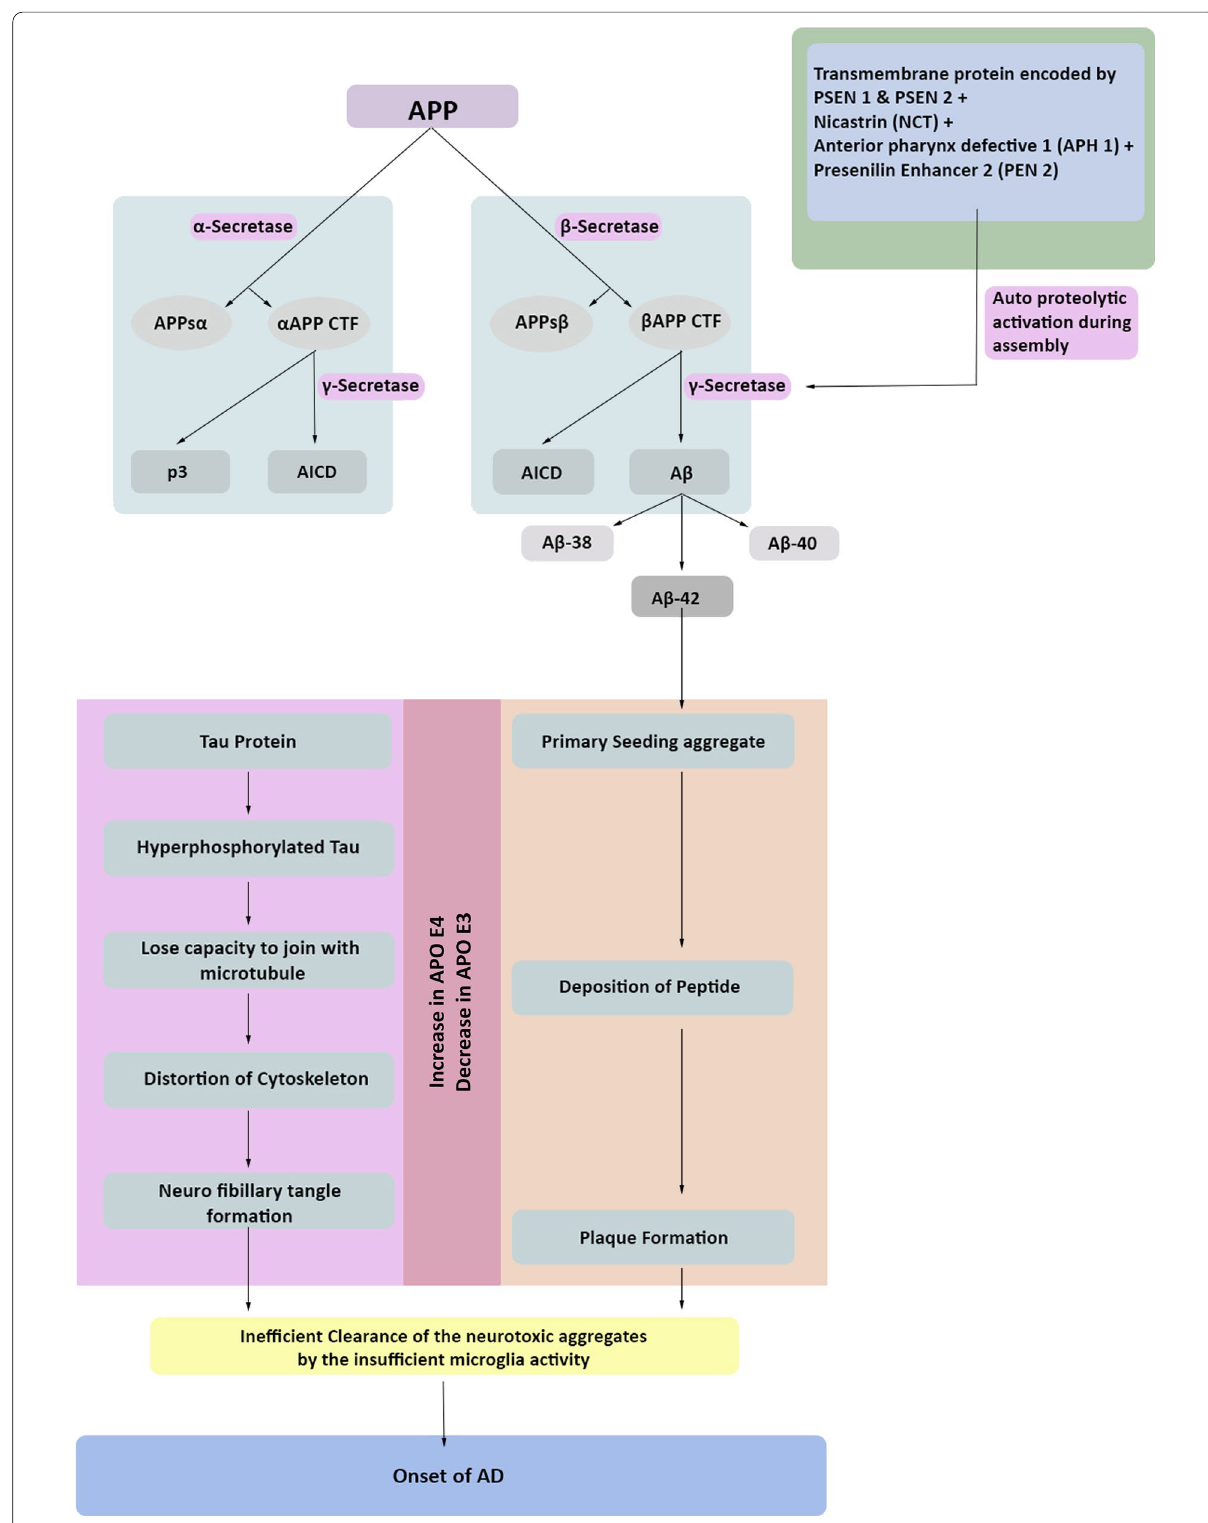
Fig. 4 AD—Overall onset pathway. The above flowchart shows the details of the mechanism which occurs during the onset of AD. The formation of Aβ-42 in turn produces primary seeding aggregate which results in the deposition of peptide thus causing plaque formation. When this plaque didn’t get cleared by insufficient microglial activity result in the AD